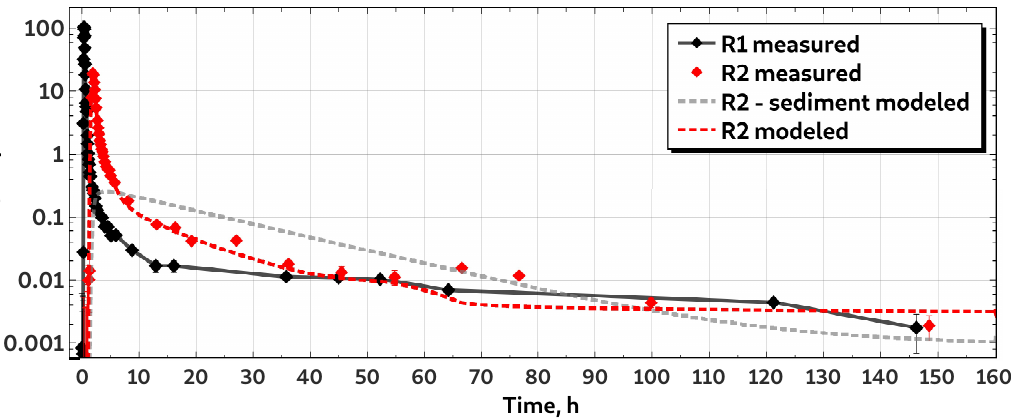
Figure 7. The 32 P activity concentrations observed at R1 and R2, and modeled at R2. Observations in sediment were not performed at R2.